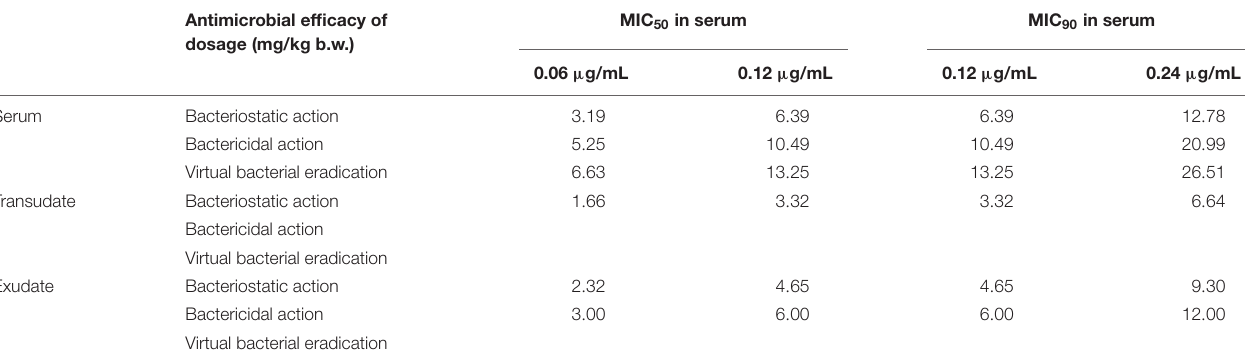
TABLE 7 | The dosage of tulathromycin for achieving corresponding antibacterial effect following i.m. administration. Antimicrobial efficacy of dosage (mg/kg